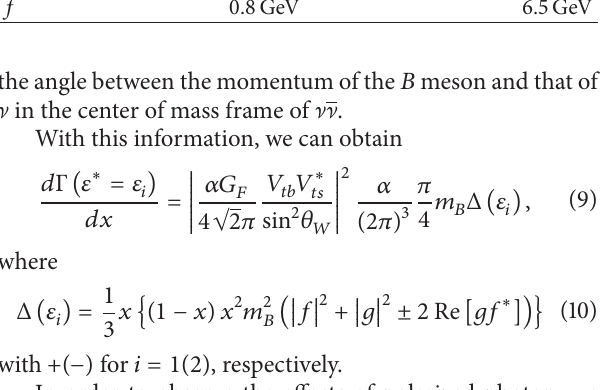
Table 1: 𝐵 meson decay form factors in the light-cone QCD sum Table 2: The values of the 𝑍 󸀠 model parameters for two different rule. scenarios. For mass of 𝑍 󸀠 boson we put 𝑚 𝑍 󸀠 = 3 𝐹(0) 𝑚 𝐹 𝑔 1GeV 5.6 GeV 𝑓 0.8 GeV 6.5 GeV